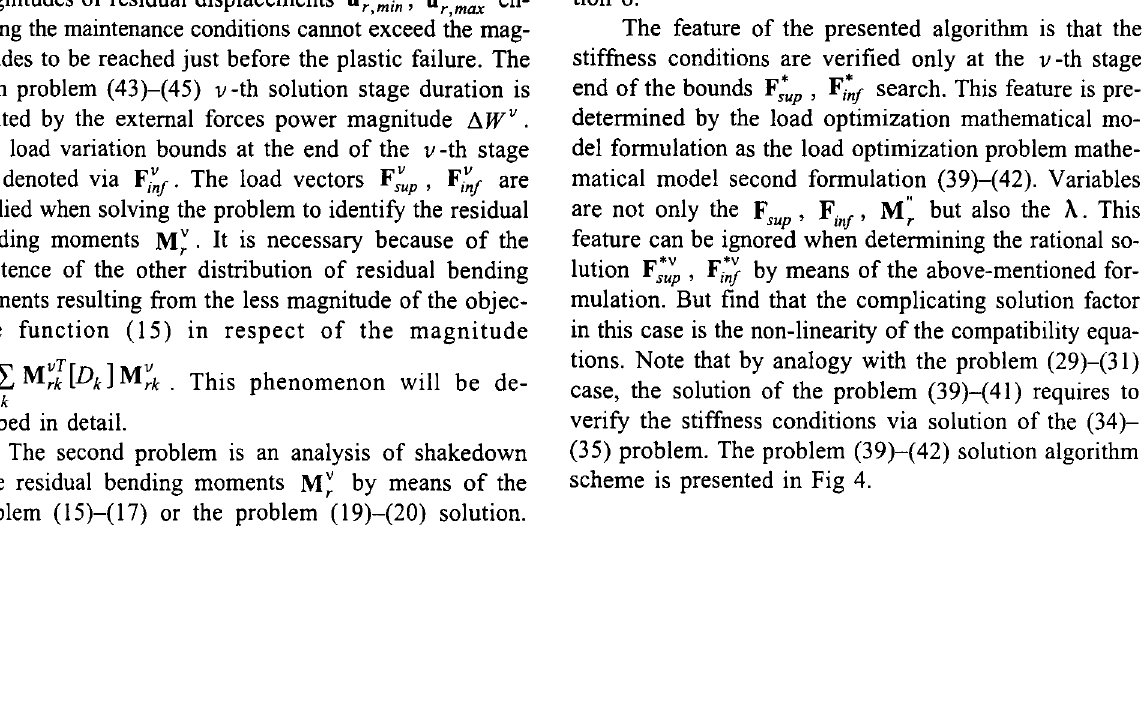
algorithm scheme is presented in Fig 3. An